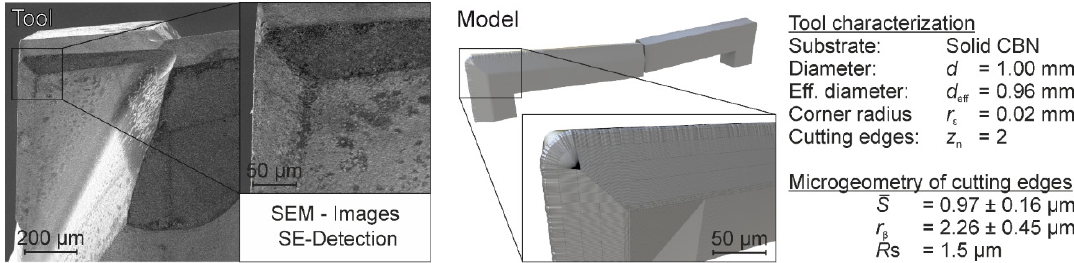
Figure 5. Simulation model of the analyzed cutter taking the microscopic geometry of a cutting edge into account.